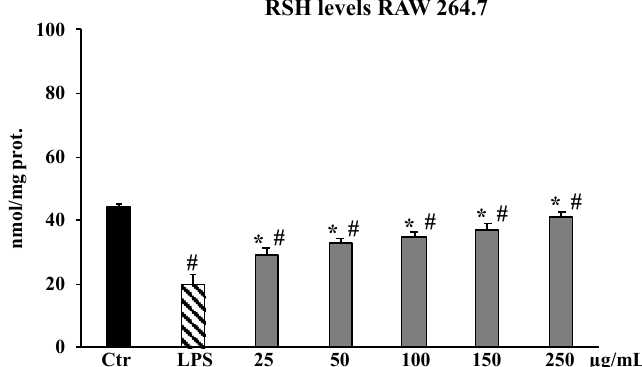
Figure 5. RSH in RAW 264.7 untreated cells: (Ctr), LPS-treated for 2 h, and pre-treated with the total extract (25–50–100–150–250 µ g/mL) for 24 h. Values are the mean ± S.D. of five experiments in triplicate. Confidence intervals calculated by two-way ANOVA and Tukey post-hoc test: # Significant vs. untreated control cells: p < 0.001; * Significant vs. LPS-treated cells: p < 0.001.